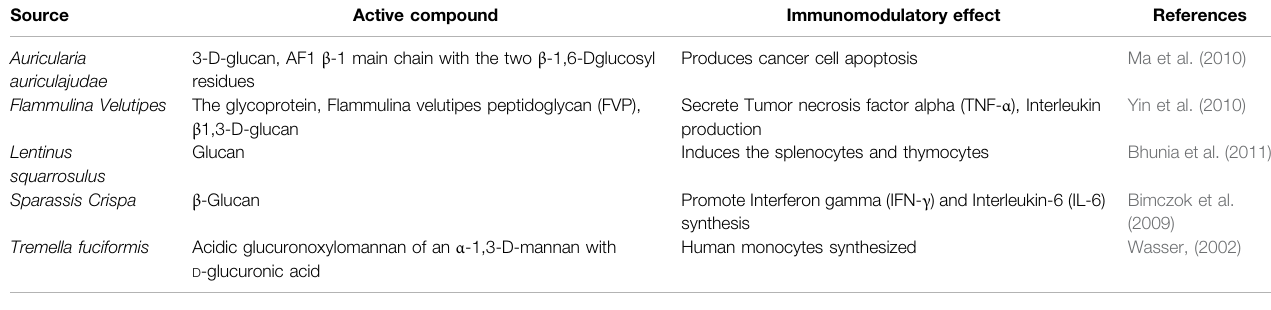
TABLE 1 | Various medicinal mushrooms derived Polysaccharides and polysaccharide-protein complexes which are immunomodulatory.